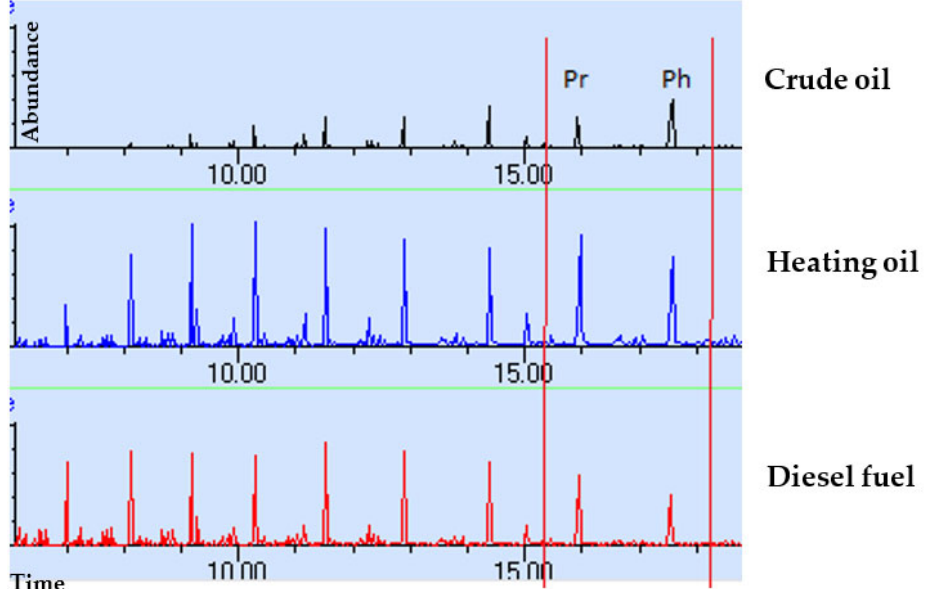
Figure 4. Comparison of Pr/Ph ratio between crude oil and petroleum products.